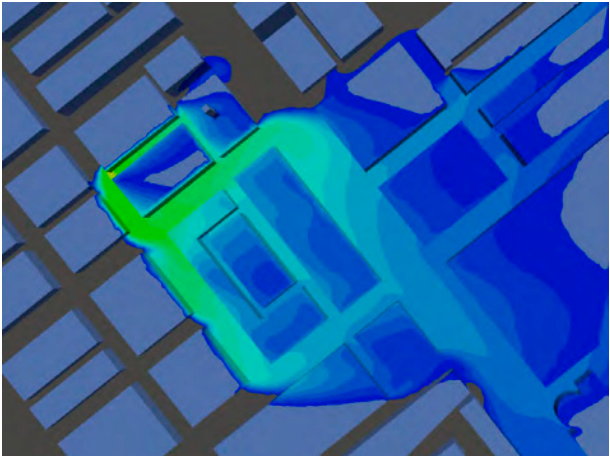
Figure 2. Example of Large Eddy Simulation (LES) solution at one instant in time for a release in a dense urban area. From Herring, S. and Huq, P., 2016, 17th International Conference on Harmonisation within Atmospheric Dispersion Modelling for Regulatory Purposes [7].